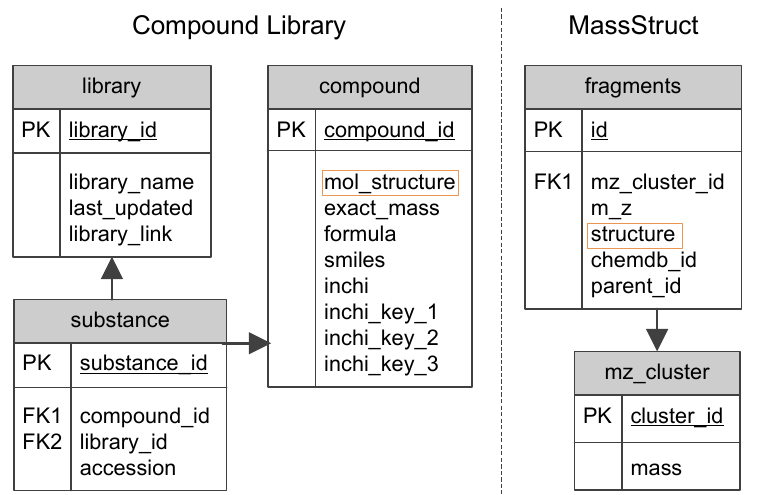
Figure 5: The tables substance and library contain the information from PubChem and other libraries, whereas compound contains the actual molecular structures. The fragments and mz cluster tables contain the structure → mass associations which were created during the training step of the